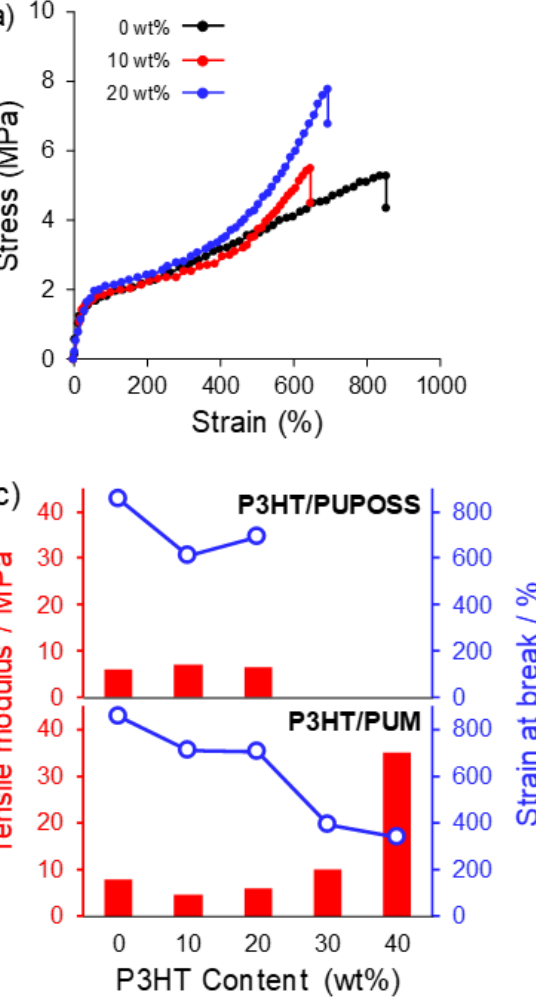
Figure 1. Stress-strain curves of ( a ) P3HT / PUPOSS and ( b ) P3HT / PUM at each amount of loaded doped P3HT. ( c ) Tensile moduli and strain values at the film breaking with P3HT / PUPOSS and P3HT / PUM. Table 1. Mechanical properties of hybrid films.